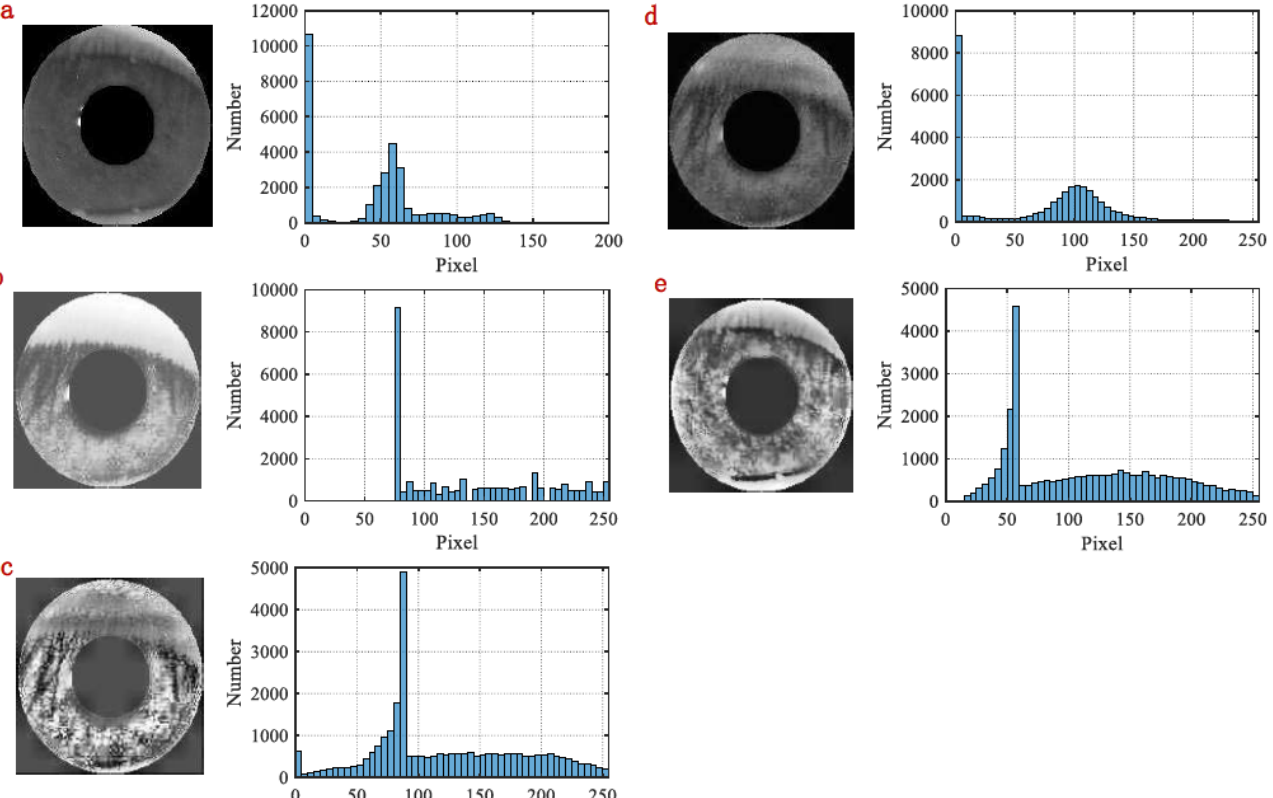
Figure 9. Comparison of iris image and histograms. ( a ) Original iris image; ( b ) iris enhanced by HE; ( c ) iris enhanced by AHE; ( d ) iris enhanced by CLAHE; ( e ) iris enhanced by proposed CPSSA-CLAHE.